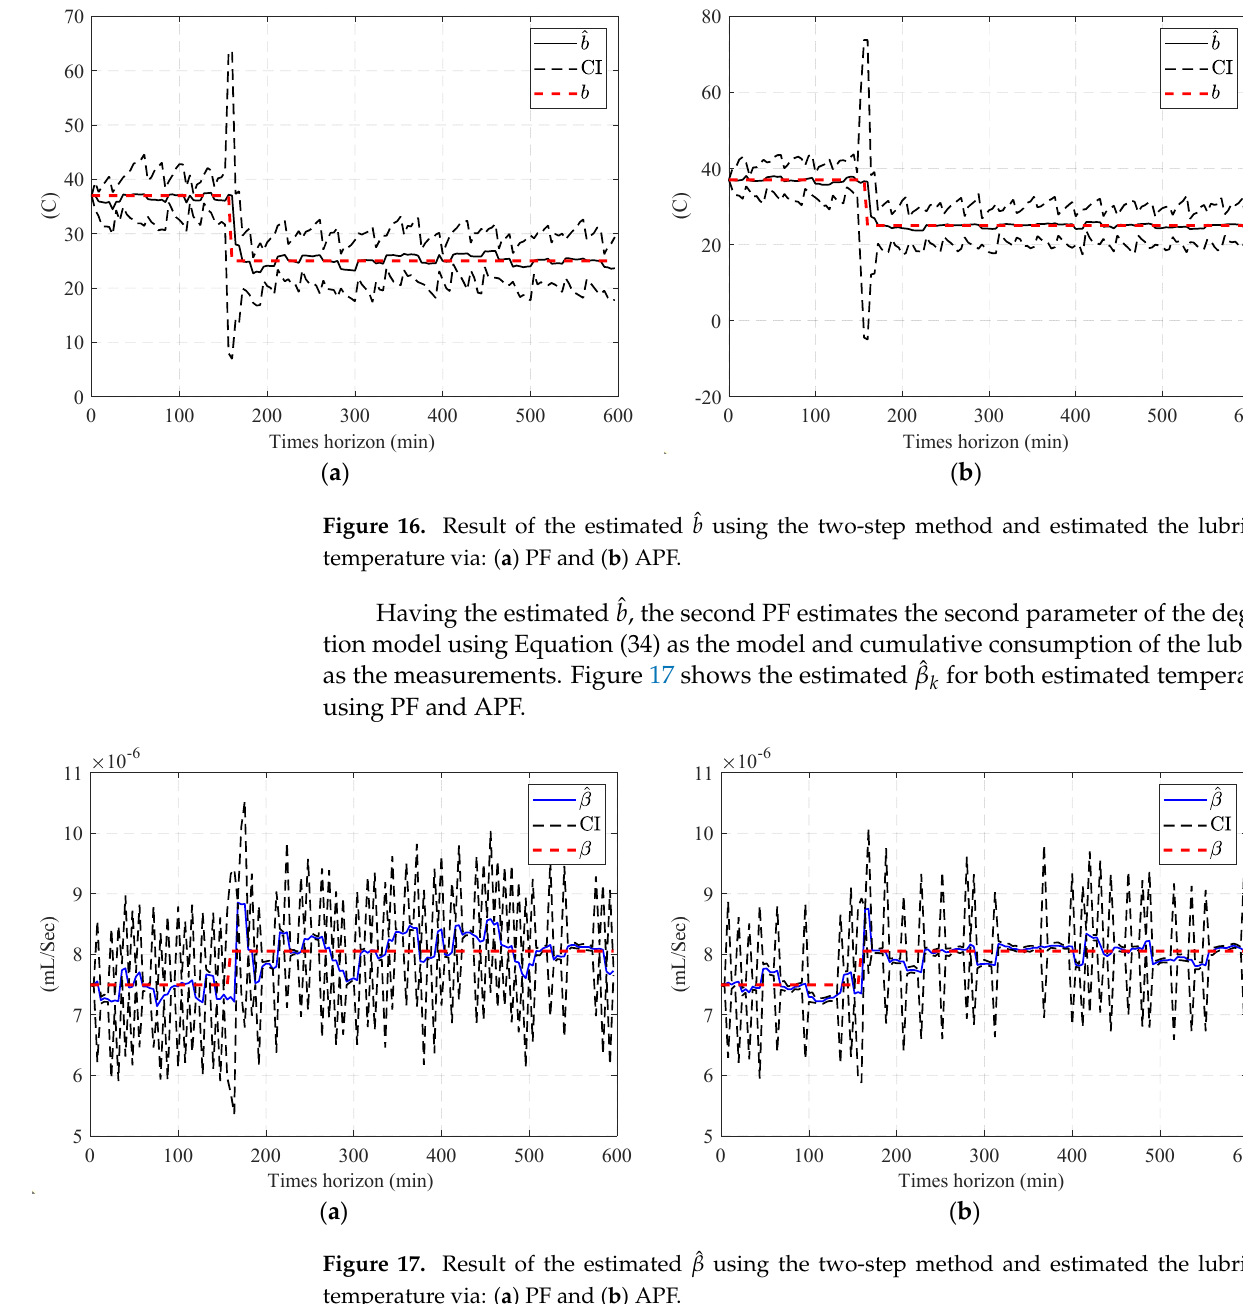
18 of 25 Figure 15. Result of the estimated lubrication consumption ( 𝑋(cid:3552) (cid:3038) − 𝑋(cid:3552) (cid:3038)(cid:2879)(cid:2869) ) using the one-step online parameter estimation method. The first PF block uses the ratio of three consecutive measurements of lubrication consumption to estimate 𝑏 using: 𝑋 (cid:3038) − 𝑋 (cid:3038)(cid:2879)(cid:2869) 𝑋 (cid:3038)(cid:2879)(cid:2869) − 𝑋 (cid:3038)(cid:2879)(cid:2870) = 𝑒𝑥𝑝 (cid:3437)𝑏 (cid:3038) (cid:3436) 1 𝑇 (cid:3038)(cid:2879)(cid:2869) − 1 𝑇 (cid:3038) (cid:3440)(cid:3441) (31) where 𝑋 (cid:3038) and 𝑇 (cid:3038) are the cumulative consumption of lubricant and the temperature of lubricant at time 𝑘 . Applying the alternation presented in Equation (29) converts Equa- tion (31) to: 𝑋 (cid:3038) − 𝑋 (cid:3038)(cid:2879)(cid:2869) 𝑋 (cid:3038)(cid:2879)(cid:2869) − 𝑋 (cid:3038)(cid:2879)(cid:2870) = (cid:3533)